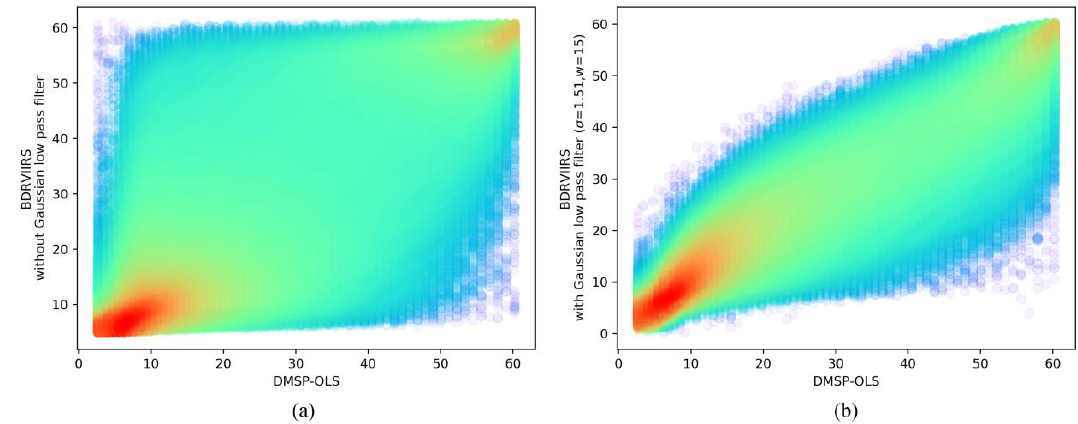
Figure 4. Surface represents the different residual sum of square (RSS) between BiDoseResp-calibrated VIIRS (BDRVIIRS) and DMSP-OLS. Blue line represents the RSS with a normal-distributional filter (σ = 1). Point a represents the RSS without a filter. Point b represents the lowest point of the surface, where σ is 1.51 and w is 15.